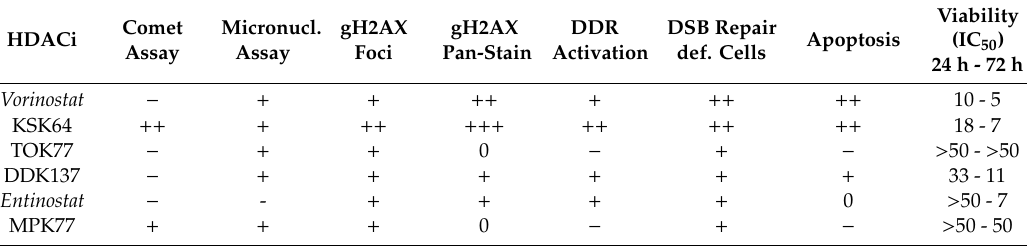
Table 1. Summary of the Genotoxic and Cytotoxic Potency of Novel Hydroxamic Acid- and Benzamide-Type